Question: Describe this figure in one sentence.
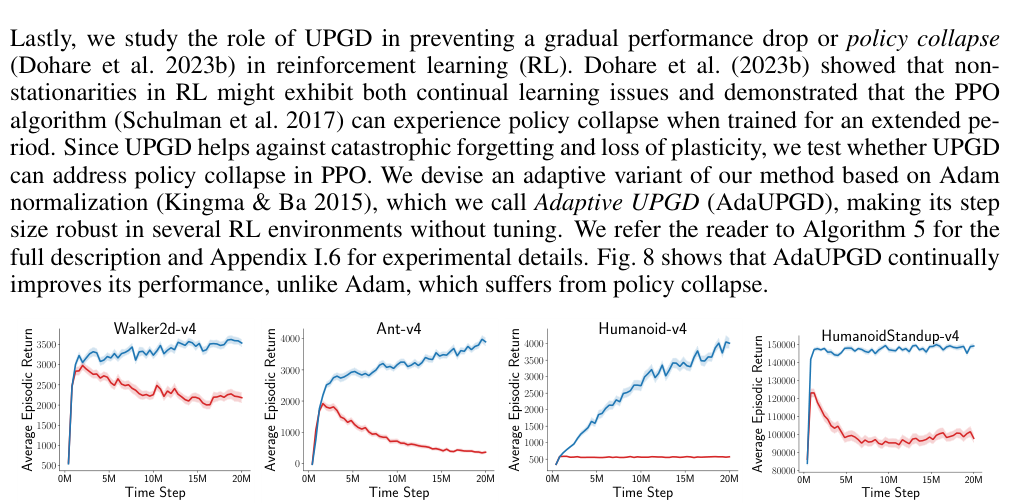
Answer: Performance of Adaptive UPGD (blue) and Adam (red) with PPO in different MuJoCo environments. The results are averaged over 40 independent runs.